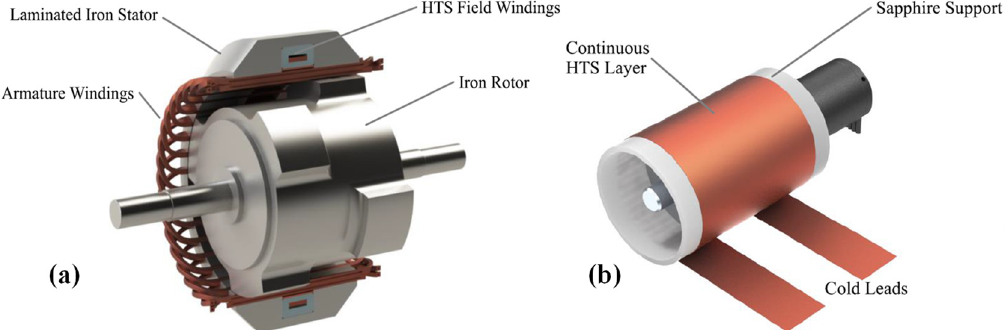
Figure 18. ( a ) Sectioned view of the AC homopolar motor/generator, ( b ) rotary HTS flux pump concept to be integrated with the field coil. Reprinted from [140].